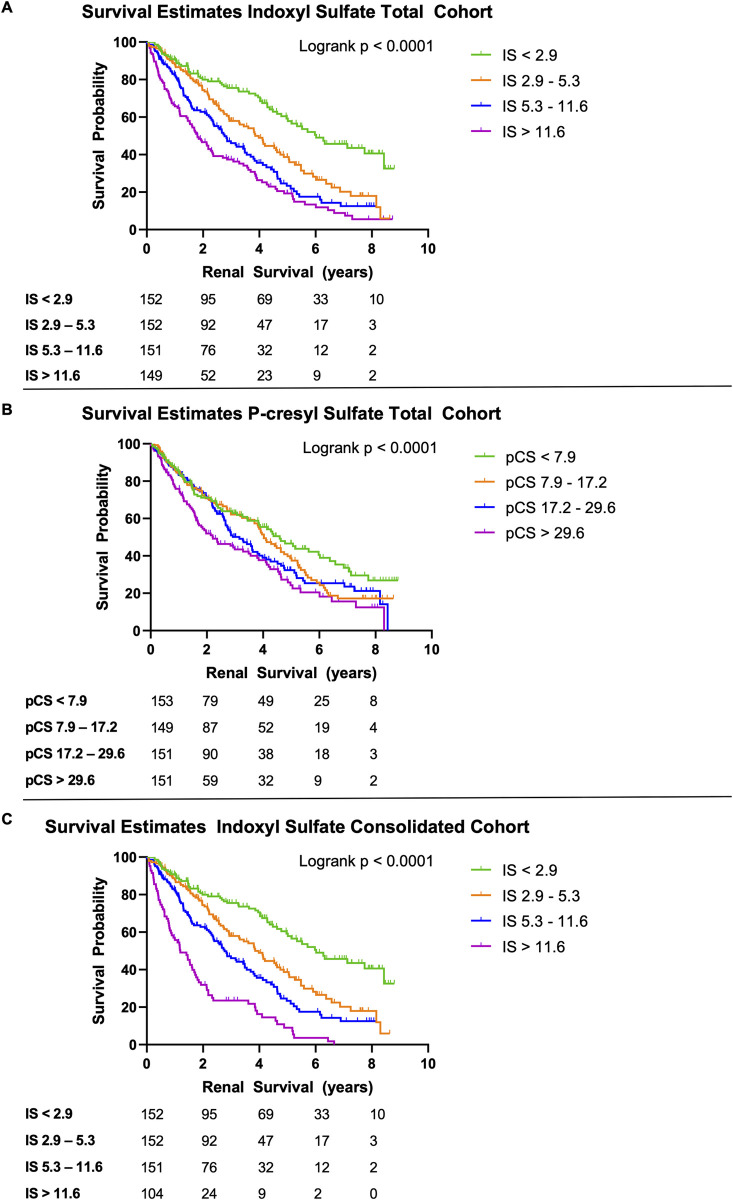
Renal survival in children with CKD according to quartiles of serum indoxyl sulfate (panels A, C) and p-cresyl sulfate (panel B). Results for total cohort (n = 604) are given in panels A and B. Panel C shows renal survival analysis by indoxyl sulfate quartiles after exclusion of patients with serum indoxyl sulfate above the 95% upper prediction limit (consolidated cohort, n = 559). Indoxyl sulfate and p-cresyl sulfate serum levels are given in μmol/l. Q1-4 indicate distribution quartiles.